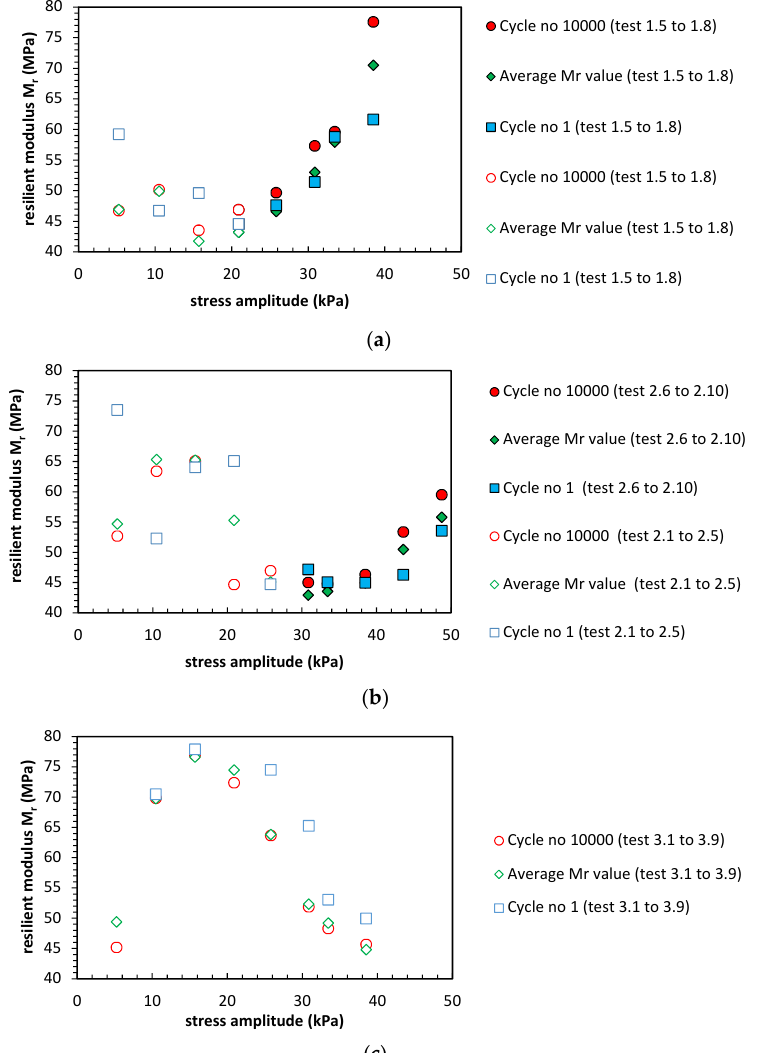
Figure 8. Resilient modulus value of tested sandy clay for different conditions: radial stress σ ’ 3 equal to ( a ) 45 kPa; ( b ) 90 kPa; and ( c ) 135 kPa, as defined in Table 2.